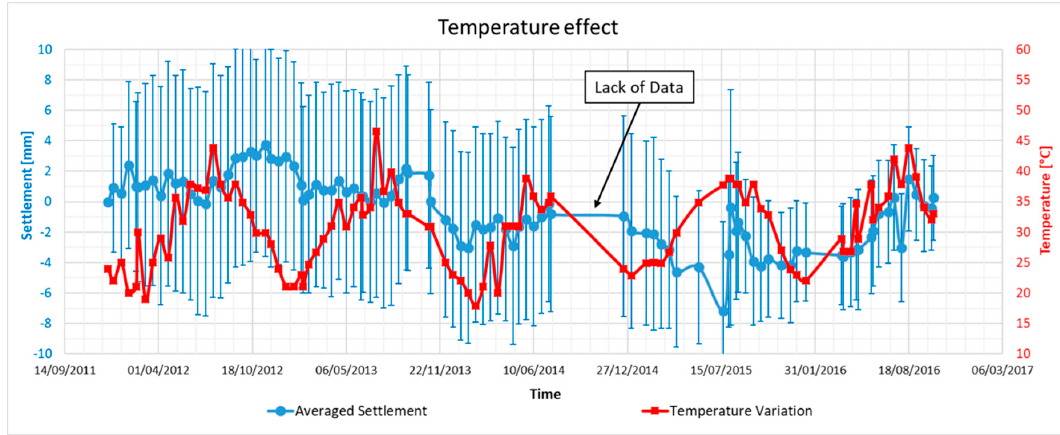
Figure 22 . Temperature variation against time compared with creep settlement